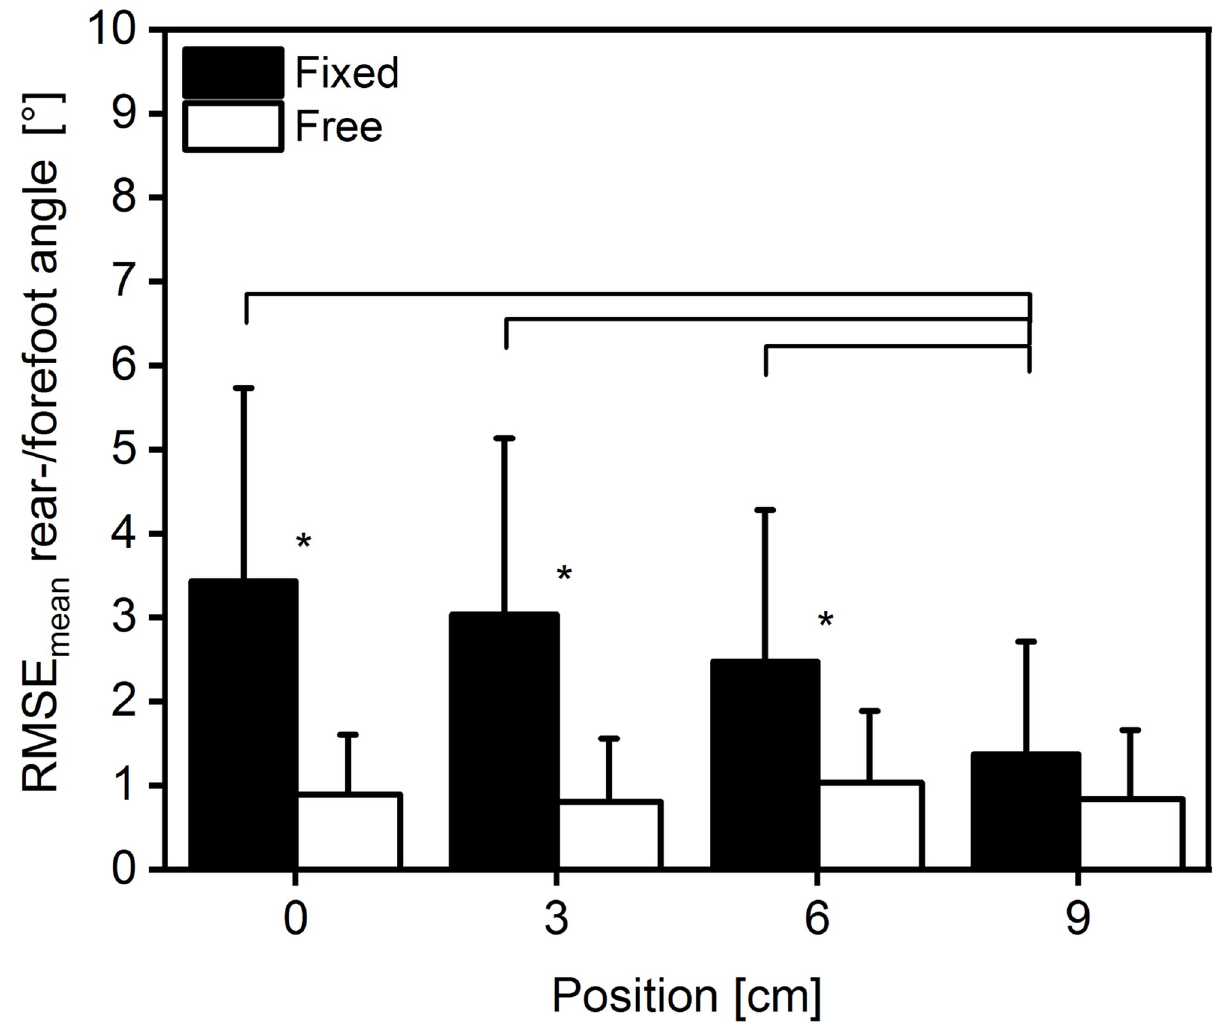
Fig 4. Root mean square error difference of joint rotation. Average (mean ± SD) root mean square error difference of the maximum ankle joint rotation, at four different positions (0–9 cm) and two different conditions (fixed = filled bars, free = empty bars). � : Indicates significant difference (p < 0.05) between conditions. Solid line: Indicates significant difference (p < 0.05) between positions (n =